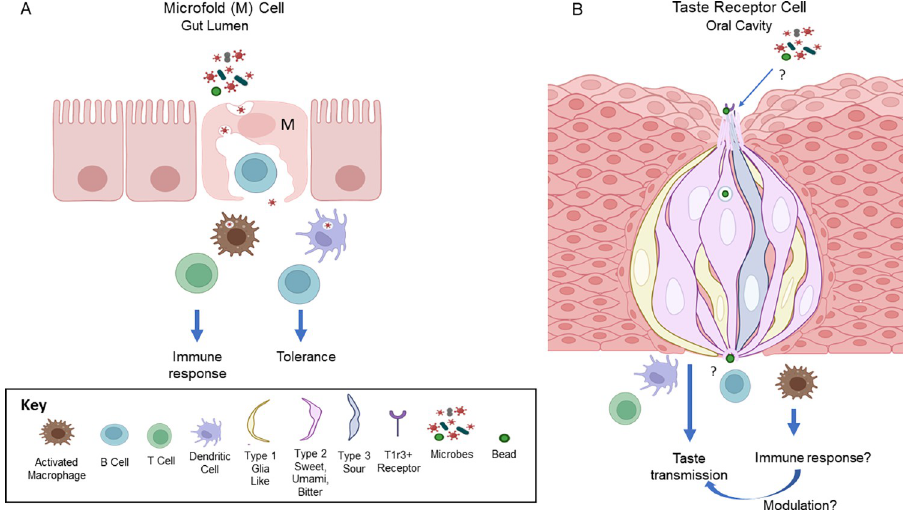
Fig 1. Microfold (M) cell surveillance of the microbiota and a similar potential role for taste cells on the tongue. (A) The gut microbiota is sampled by M cells that deliver bacteria and viruses across the epithelial layer to underlying immune cells, triggering immune responses or tolerance in the mucosa. The M cell pocket is occupied by a B lymphocyte that directs the maturation of M cell function. (B) Heterogeneous groups of taste cells on the tongue form taste buds surrounded by epithelial cells. Unlike M cells, taste cells are tipped by microvilli projecting into the oral cavity. A new study by Qin and colleagues demonstrates that sweet- and umami-sensing T1r3 + cells also express signature M cell genes such as the transcription factor, Spib . Wild-type taste buds take up fluorescent latex beads similar to M cells but uptake is reduced in Spib KO taste buds. Immune cell density under taste buds is also diminished in the absence of Spib . Whether taste cells can transport beads or microbes to immune cells and trigger immune responses remains to be tested. Intriguingly, Spib KO mice had increased licking responses to sucrose and umami tastants though the significance of taste changes is unknown. This exciting new study indicates a novel role of some taste cells in sampling the oral microbiome in homeostasis and during infection. This figure was created with